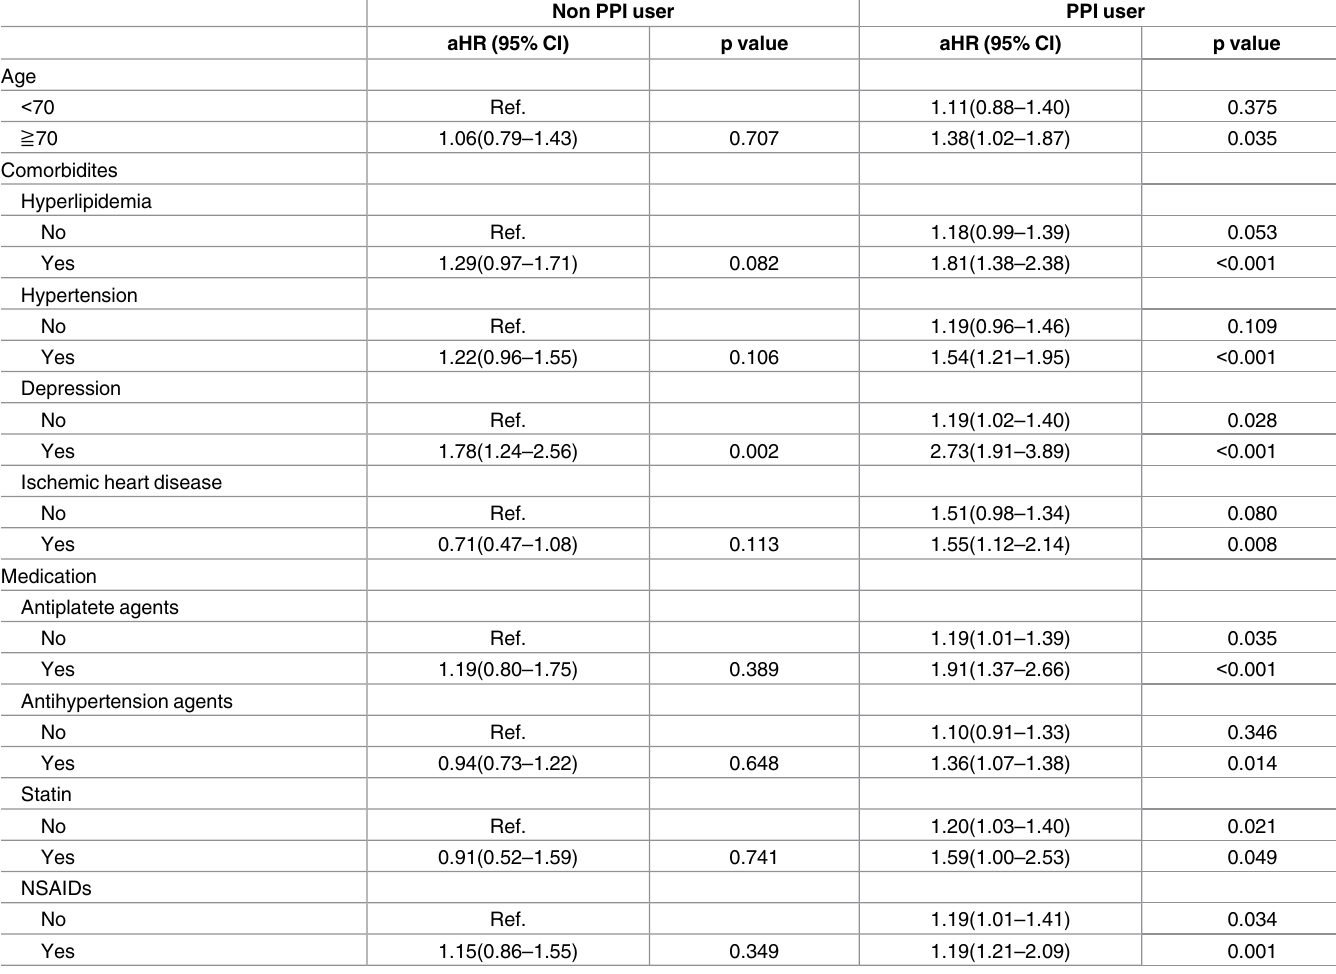
Table 3. The additive effectsof covariates on all cause dementia between non PPI user and PPI user (N =